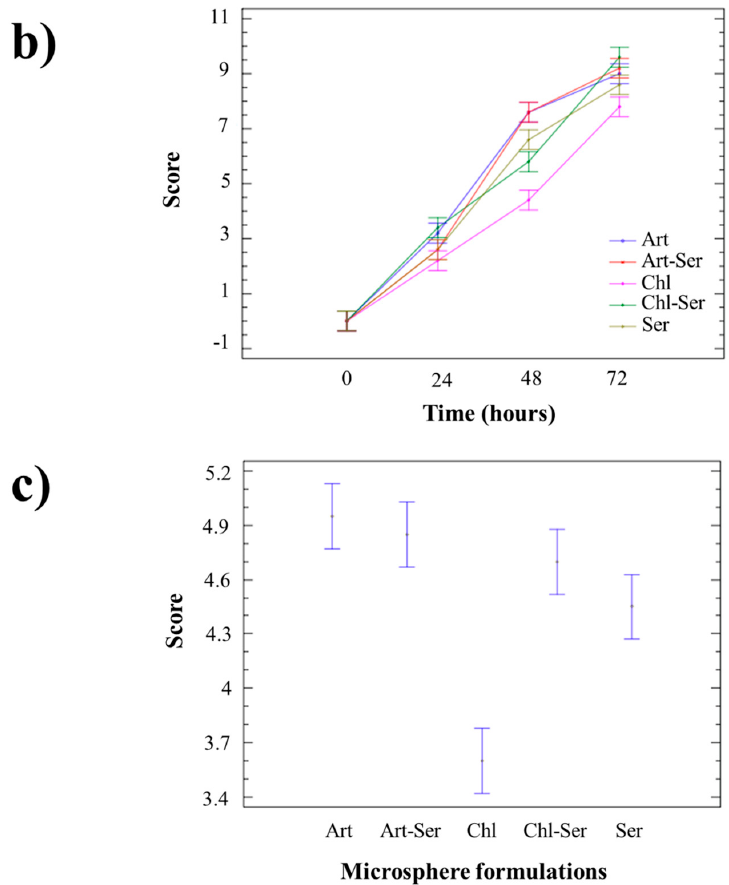
Figure 6. ( a ) Representative images of scratched fibroblast migration after treatment with microspheres. Mean values of wound healing scores and 95.0 percent LSD (Least Significant Difference) intervals, considering ( b ) time of treatment and ( c ) microsphere formulations.